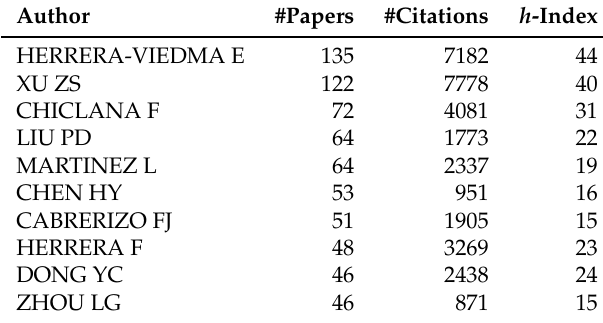
Table 1. Most prolific authors.